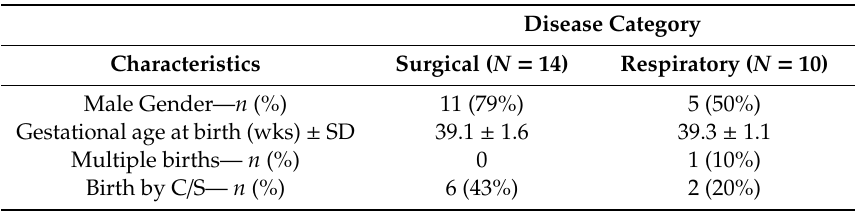
Table 1. Demographic Characteristics. Summary of demographic characteristics of full-term patients in the surgical and respiratory disease groups that were included in the comprehensive data analysis. Such analysis excluded any full-term infants with known neurological disease.